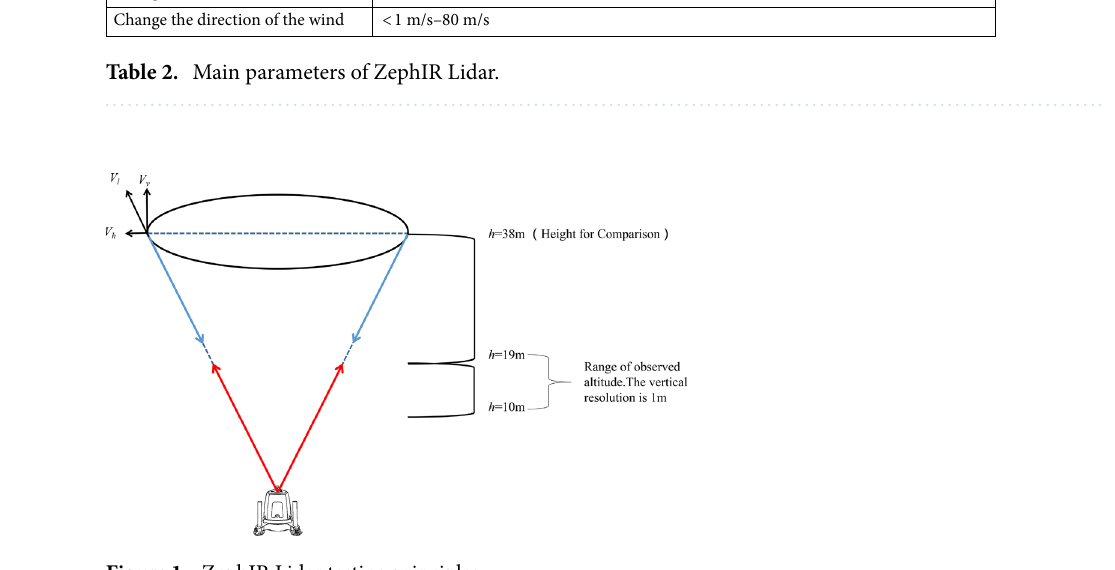
Figure 1. ZephIR Lidar testing principles.